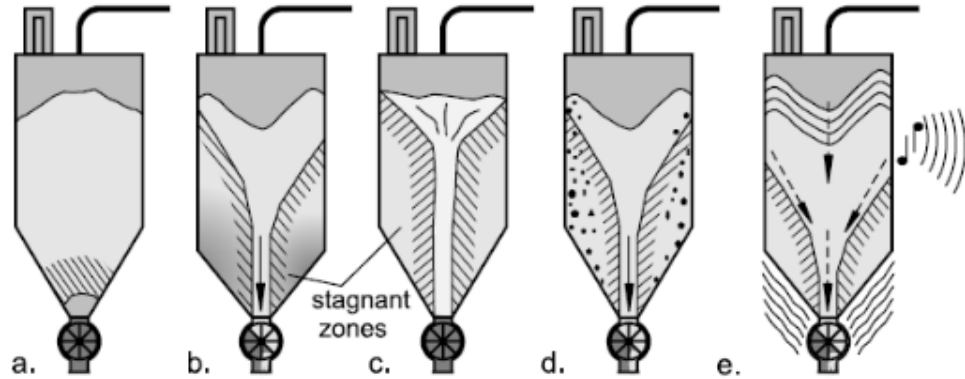
Figure 5. Types of obstructions in the flow of bulk solids: ( a ) arching ( b ) funnel flow with long residence times ( c ) ritholing ( d ) segregation ( e ) noise and vibrations